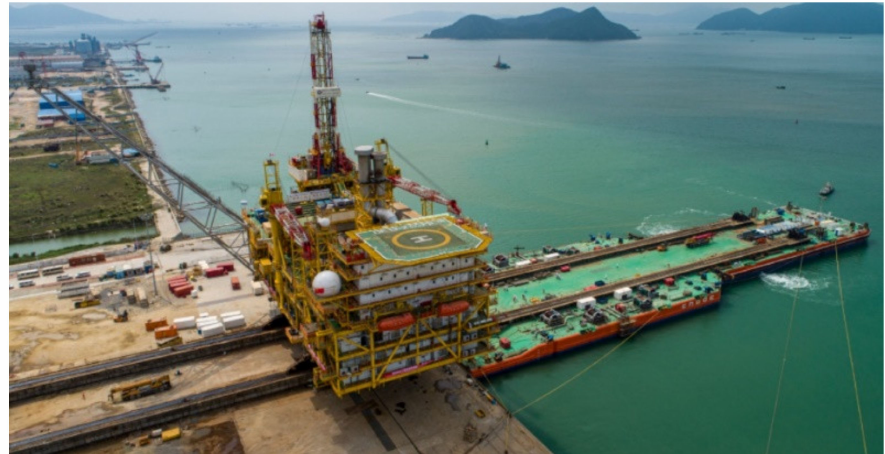
Figure 9. Load-out 18,000 t topside and transportation from a yard in Zhuhai, China (Courtesy: Ocean energy resource).